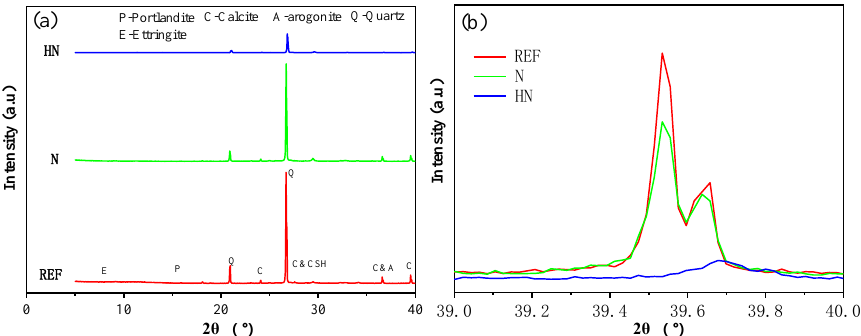
Figure 5. XRD patterns of different samples after carbonation: ( a ) overall patterns and ( b ) partial enlarged view of patterns near 39°.